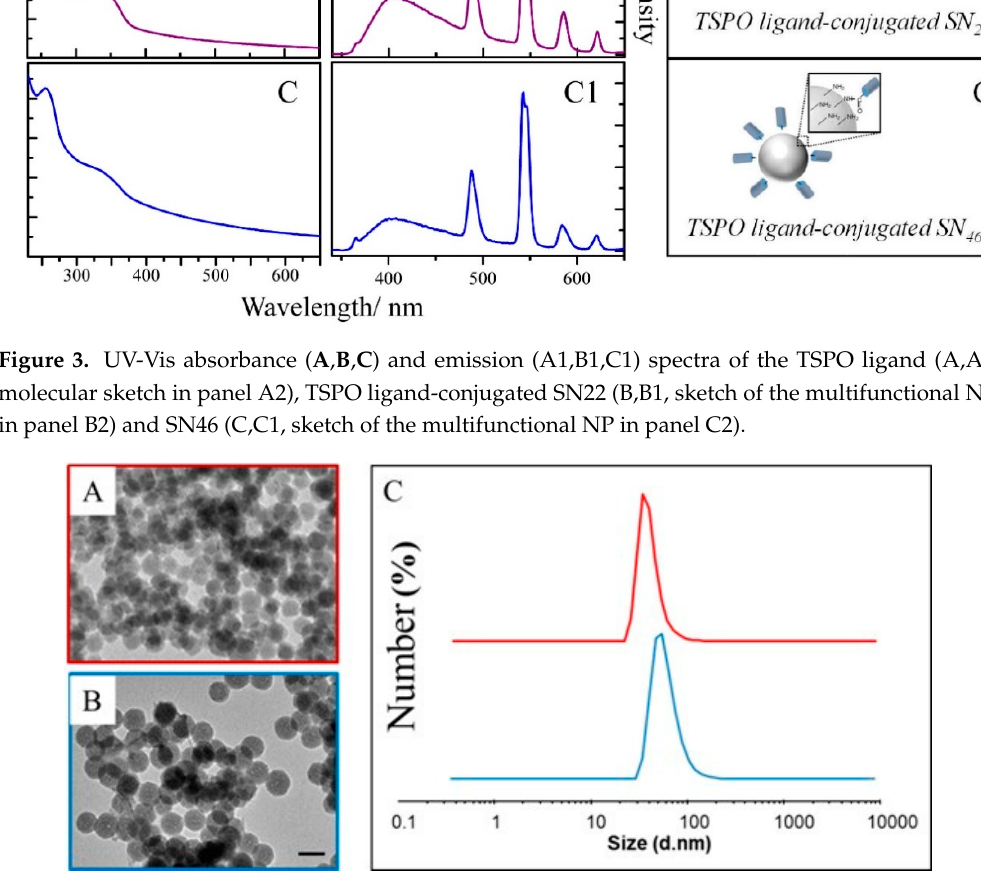
Figure 4. TEM micrographs and size distribution measured by DLS analysis of the TSPO ligand conjugated SN22 ( A , C violet line) and SN46 ( B and C blue line).